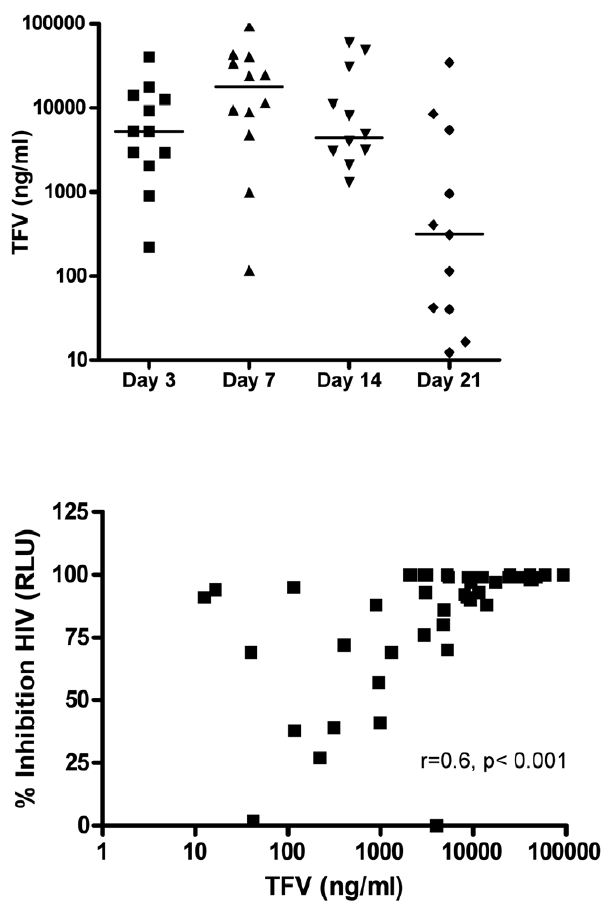
Figure 4. CVL tenofovir levels correlate with anti-HIV activity in CVL. The concentration of TFV was determined in CVL samples collected on Days 3, 7, 14 and 21 (upper panel). Each data point represents the TFV level obtained from a single CVL sample, with the median for each group represented by a horizontal line. CVL TFV concentrations correlated positively and significantly with percentage inhibition of HIV (lower panel).